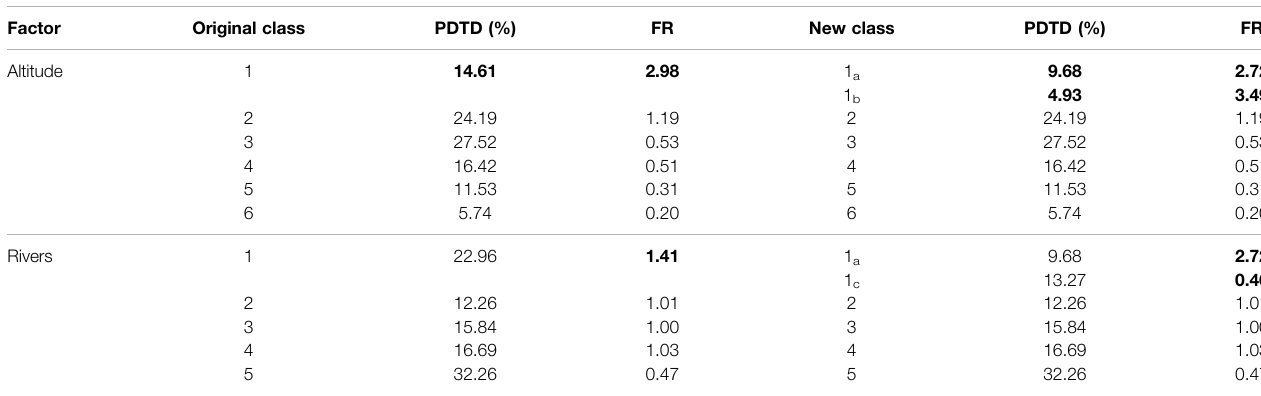
TABLE 7 | Reclassi fi cation of the altitude and distance to rivers factors.